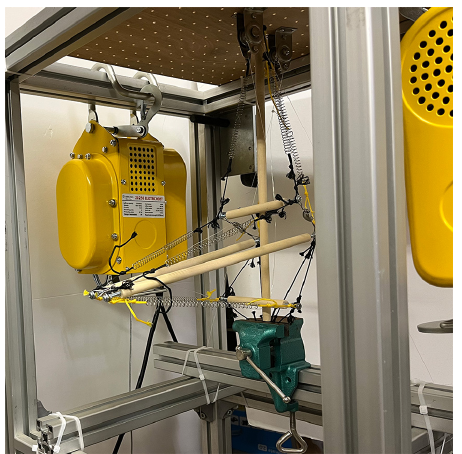
Figure 21. The tip of the lower arm is controlled upward by the electric winch.